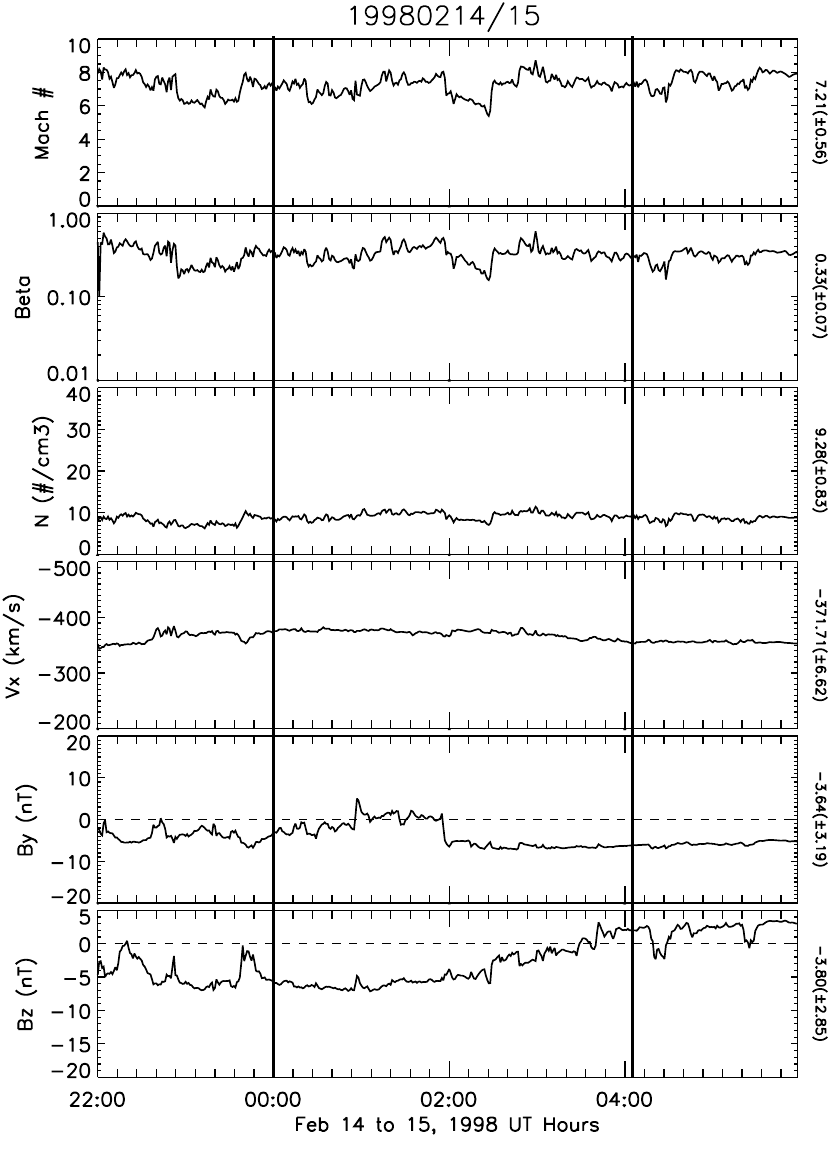
Fig. 5. Propagated ACE data for the BRI on 14 and 15 February 1998 (Event 2). The set up is the same as Fig. 3.